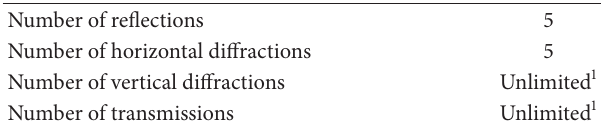
Table 1: Simulation